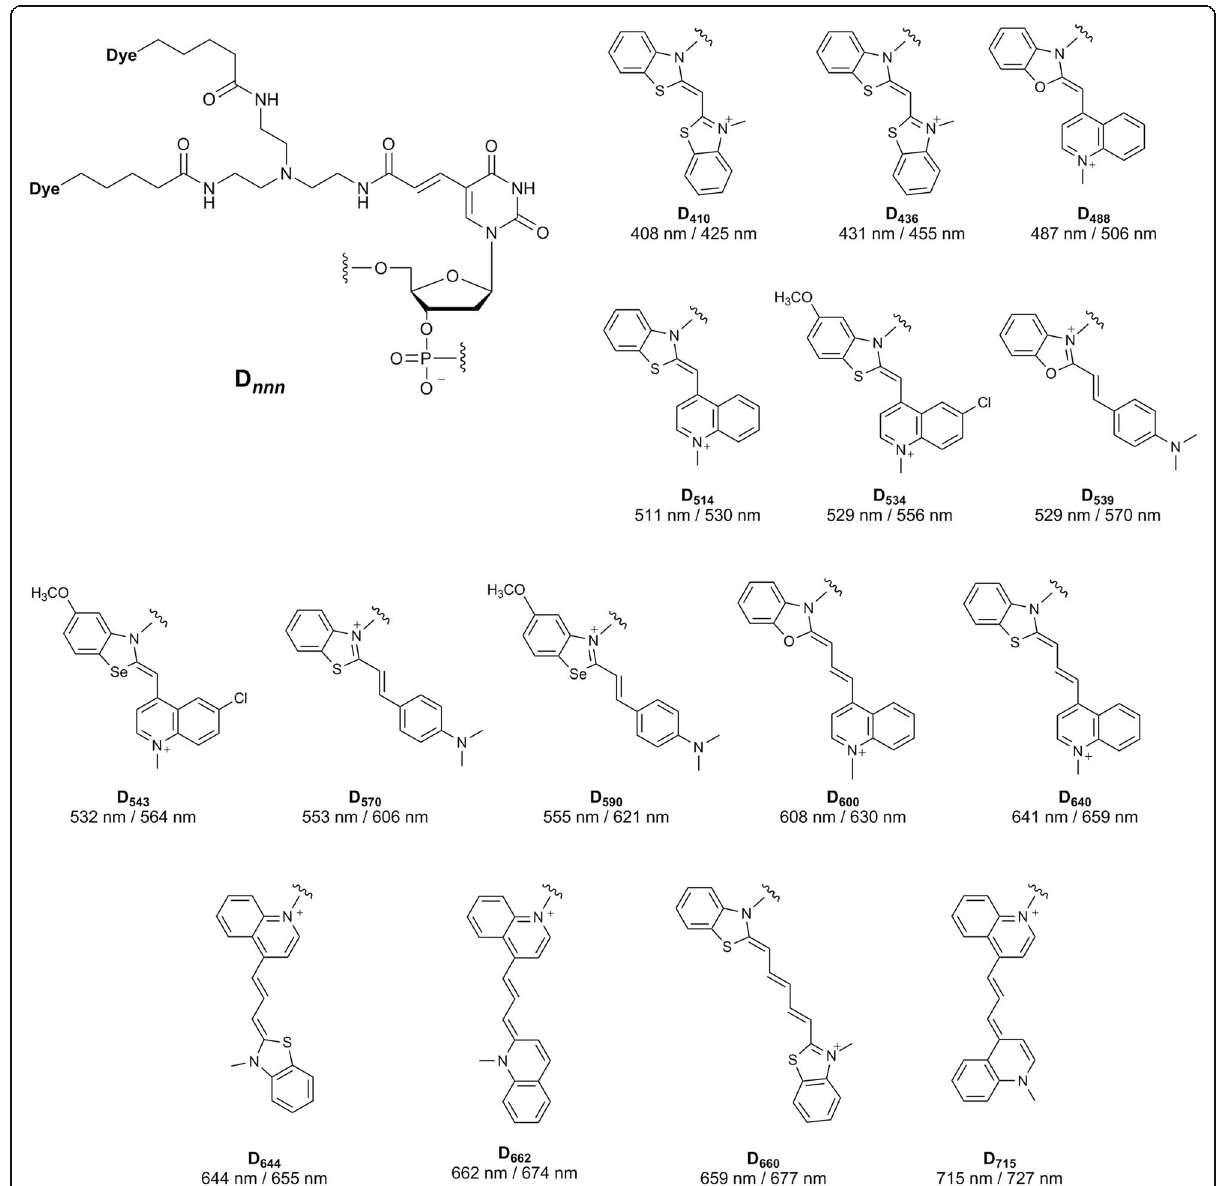
Fig. 2 A series of doubly fluorescence-labeled nucleotides (D nnn ) used in ECHO probe. Chemical structures of D nnn are drawn with their excitation/emission